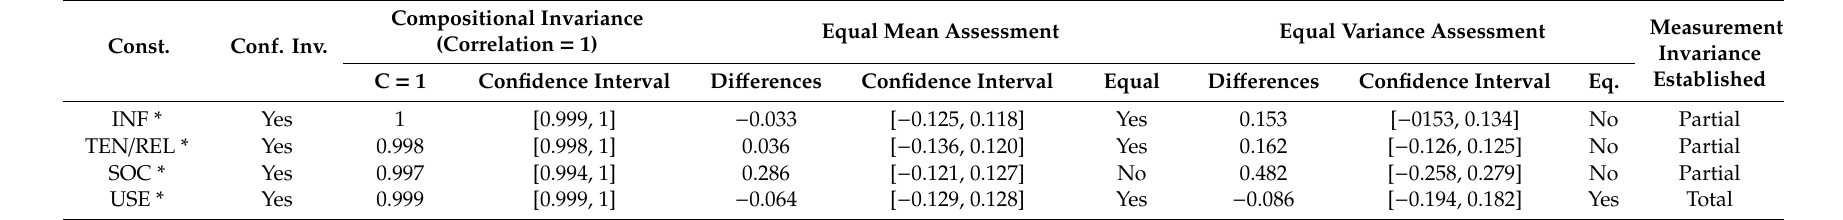
Table 5. Results of invariance measurement testing using permutation (self-perception of level as a player). Const. Conf.